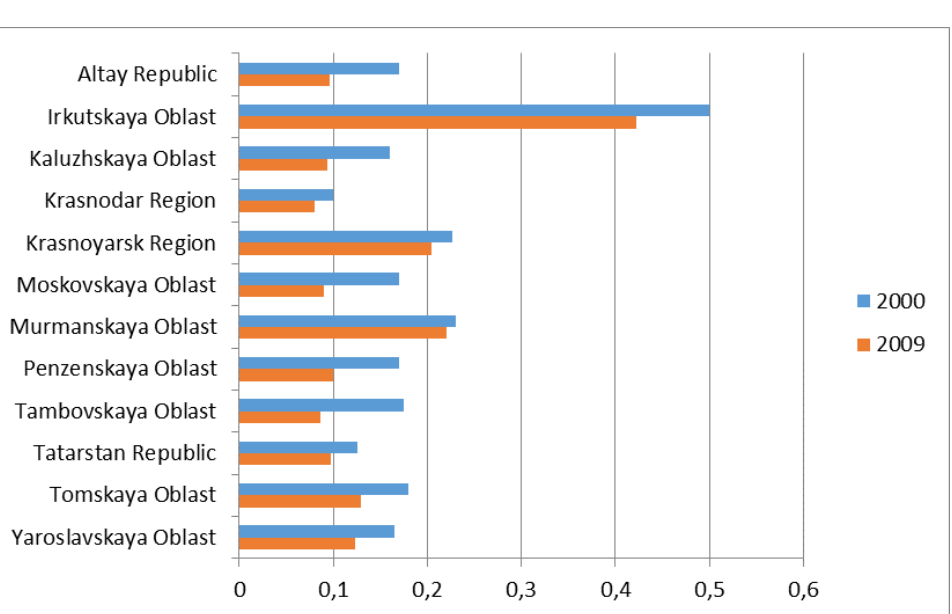
Figure 3: Changing in electrical energy intensity of some regional GDP during 2000-2009 (mill kWh/thous. rub) Source: Author own study